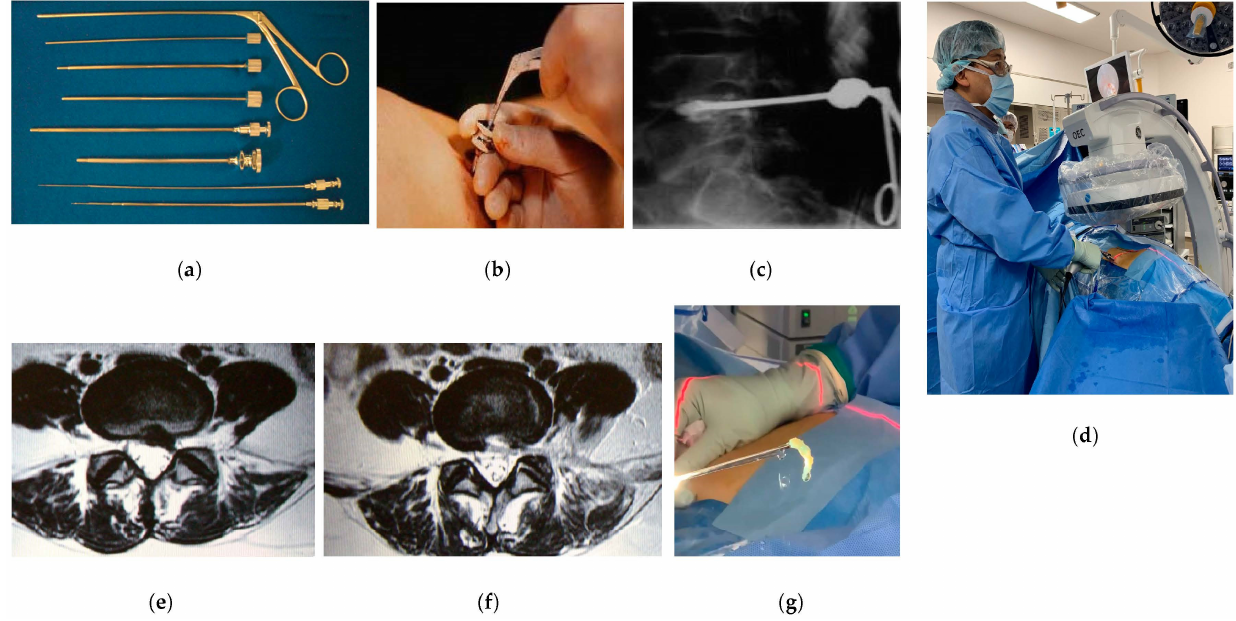
Figure 1. Percutaneous nuclectomy (PN) and percutaneous endoscopic discectomy (PED)/full-endoscopic spine surgery (FESS). ( a ) Dilation device of PN; ( b , c ) intraoperative images of PN; ( d ) intraoperative image of PED/FESS; ( e ) preoperative MR image; ( f ) postoperative MR image; ( g ) resected herniation by